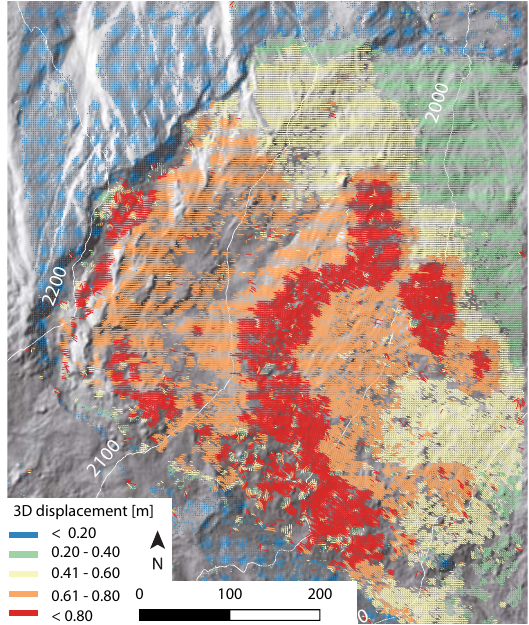
Figure 5. 3D displacement vectors obtained between 28 June 2016 and 26 June 2017 (period02).